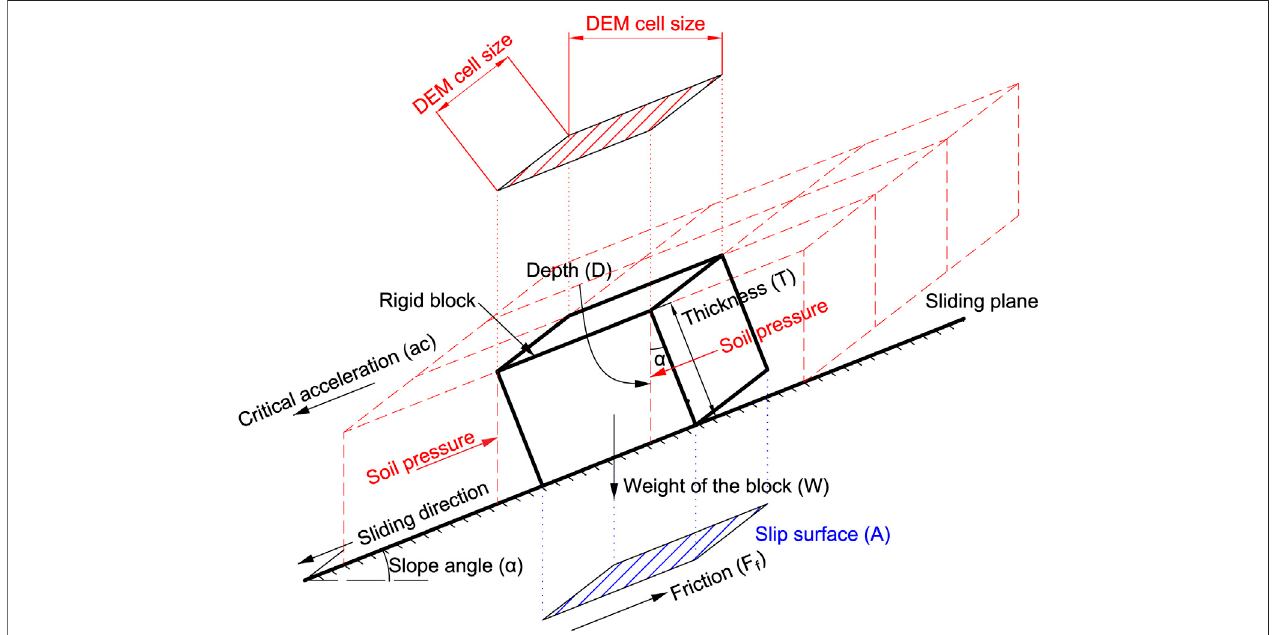
FIGURE 5 | Schematic diagram illustrating the forces acting on a block resting on an inclined plane for static (pre-earthquake) conditions on a GIS environment.